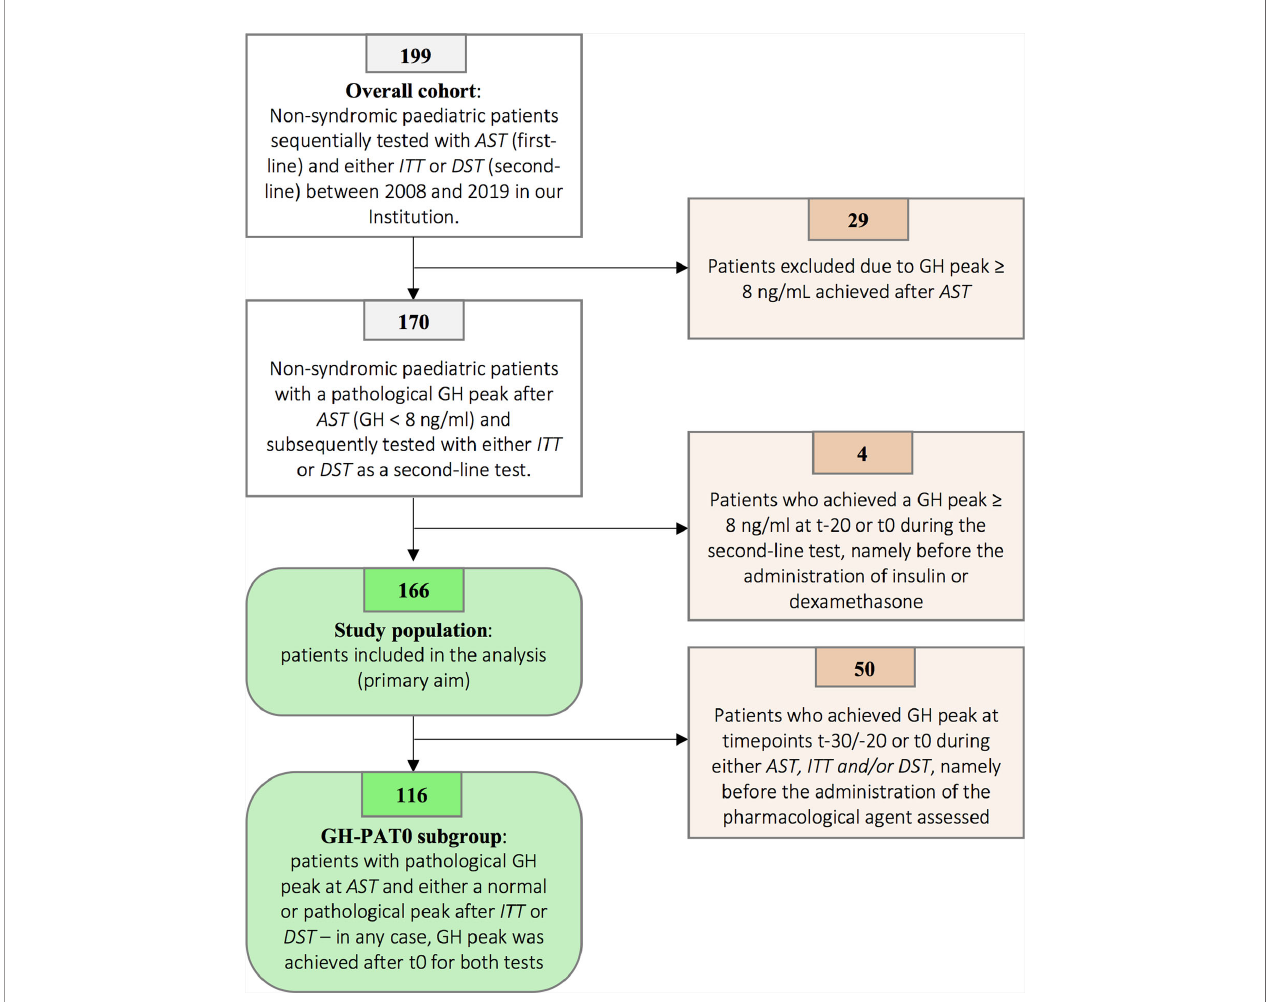
FIGURE 1 | Patients ’ selection fl owchart. Among 199 patients initially tested with AST and subsequently with either ITT or DST , 29 presented with a peak value achieved after AST ranging from 8.00 to 9.99 ng/ml. According to the previous versions of the Italian national guidelines, GH peaks below 10.00 ng/mL were recorded as pathological and patients therefore underwent a second con fi rmatory stimulation test. In order to harmonize the result according to the latest versions of the Italian guidelines (normal GH peak ≥ 8.00 ng/ml), 29 patients with GH peaks ≥ 8.00 ng/ml were excluded. Four out of the remaining 170 patients have been excluded as a normal GH peak at second-line test was achieved at t-20 or t0. As a consequence, the diagnostic role of either ITT or DST could not be assessed, as the peak (classi fi ed as normal) was irrespective of the kind of pharmacological agent administered. Overall, 166 patients were included in the analysis and represented the study population. Finally, in order to speci fi cally assess the direct effect of insulin and dexamethasone on GH secretion (secondary endpoints), we identi fi ed 116 patients to be included in the GHPAT-0 (GH Peak After Time 0) subgroup. Indeed, in 50 amongst the 166 patients included in the study the GH peak was achieved before the administration of the pharmacological agent and thus did not allow to assess the differential contribution of insulin and dexamethasone on pituitary